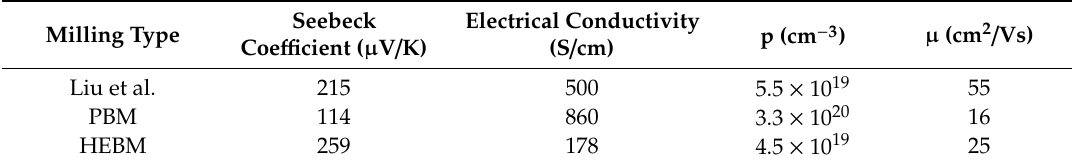
Table 2. Estimated carrier concentration and mobility at room temperature of the pellets synthesized with di ff erent ball-milling